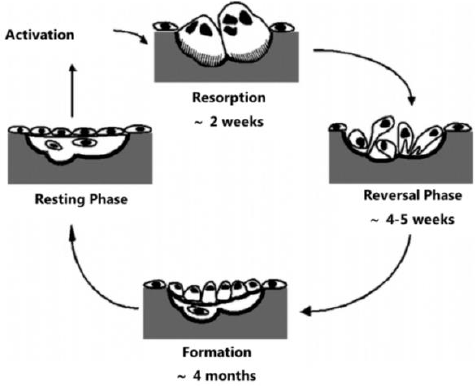
Figure 4. Bone remodelling cycle. Adapted from [1]. Figure 3. Bone remodelling cycle. Adapted from